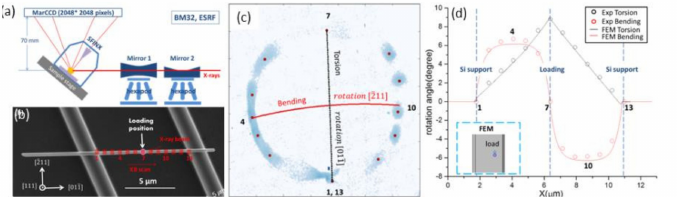
Figure 13. ( a ) Schematic representation of the experimental setup on the BM32 line. ( b ) Scanning electron microscopy image of a self-suspended Au nanowire before deformation. Measurement positions along the nanowire during KB scans are marked with rectangles and the scan direction is indicated by the arrow. ( c ) Magnified view of the area around the Au 222 diffraction peak for a tip displacement of 1100 nm. The expected movements of the Laue spot on the detector for pure vertical (cid:3) (cid:2) bending (rotation around the Au direction 211 ) and pure torsion (rotation around the Au direction (cid:3) (cid:2) 011 ) are marked respectively in red and black lines. ( d ) Bending and torsion profile along the suspended part of the nanowire deduced from the integrated Laue micro-diffraction diagram shown in ( c ) and calculated by simulations by the finite element method, considering a force of 2.1 µ N and misalignment of the SFINX tip with respect to the center of the nanowire by 57 nm [129]. Reproduced from [129] with the permission of AIP